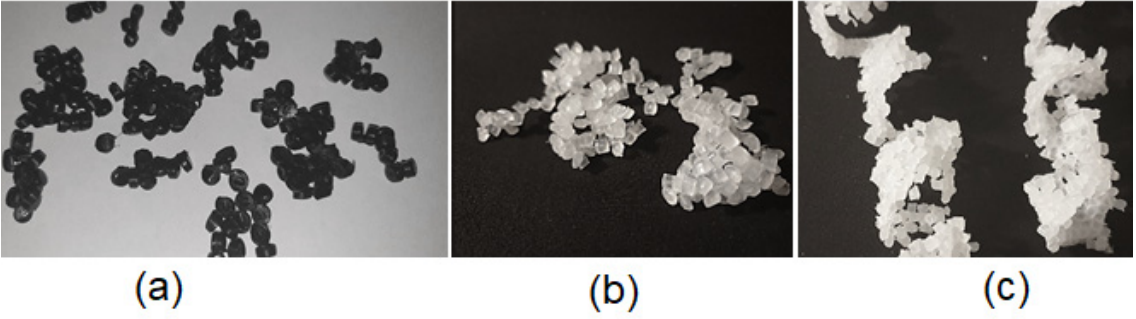
Figure 4. Partial clumping of ( a ) PE-HD, ( b ) PP and ( c ) PA granules when using a grooved barrel despite utilizing an additional water cooling.